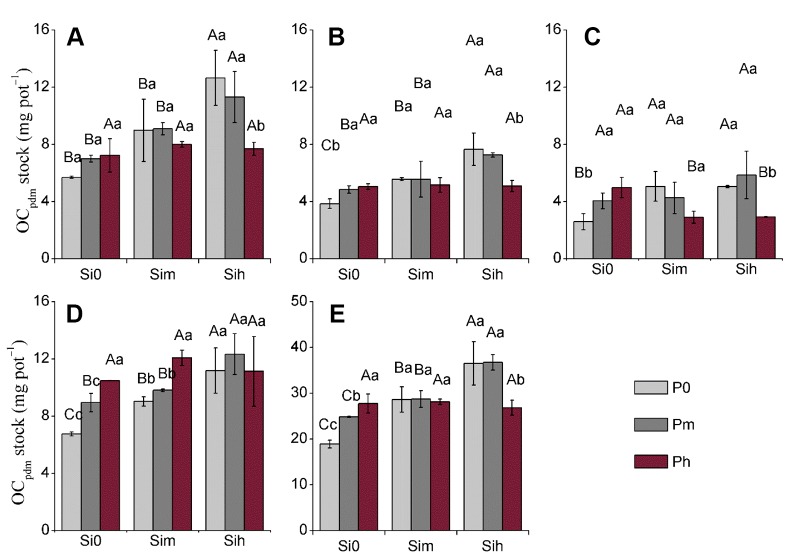
Stock of OCpdm (mg pot−1) at two-way analysis of variance of silicon-phosphorus (Si-P) levels in the different plant parts. (A) Leaf; (B) flag leaf; (C): stem; (D): sheath; (E) rich shoot. Error bars represent the standard deviations of the means. Different lowercase letters indicate significant differences among the treatments in different P treatments and rice plant parts at a given Si level, respectively [least significant difference (LSD) test; p < 0.05]. Different uppercase letters indicate significant differences among the treatments in different Si treatments and rice plant parts at a given P level, respectively (LSD test; p < 0.05, n = 5).